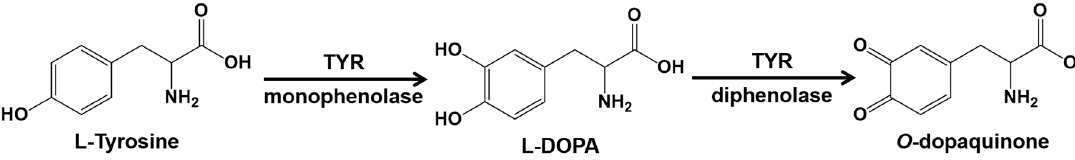
Figure 2. Melanogenesis stages catalyzed by the tyrosinase (TYR) enzyme.